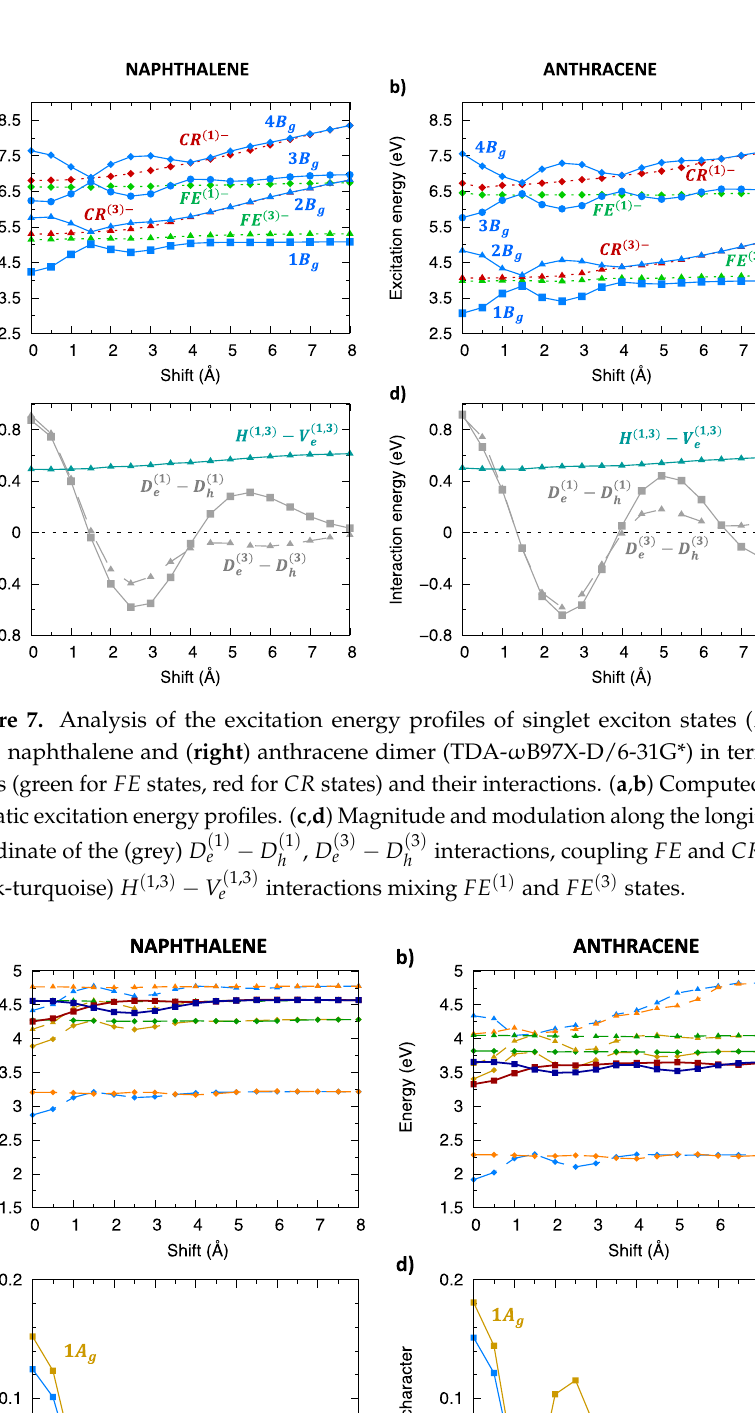
Figure 6. Analysis of the excitation energy profiles of singlet exciton states ( 𝐴 𝑔 symmetry) for (left) naphthalene and (right) anthracene dimer (TDA- ωB97X -D/6-31G * ) in terms of SA diabatic states (green for 𝐹𝐸 states, red for 𝐶𝑅 states) and their interactions. (a, b) Computed adiabatic and SA diabatic excitation energy profiles. (c, d) Magnitude and modulation along the longitudinal transla- tion coordinate of the (grey) 𝐷 𝑒(2) − 𝐷 ℎ(2) , 𝐷 𝑒(4) − 𝐷 ℎ(4) interactions, coupling 𝐹𝐸 and 𝐶𝑅 states, and of the (dark-turquoise) 𝐻 (2,4) − 𝑉 𝑒(2,4) interactions mixing 𝐹𝐸 (2) and 𝐹𝐸 (4) states.